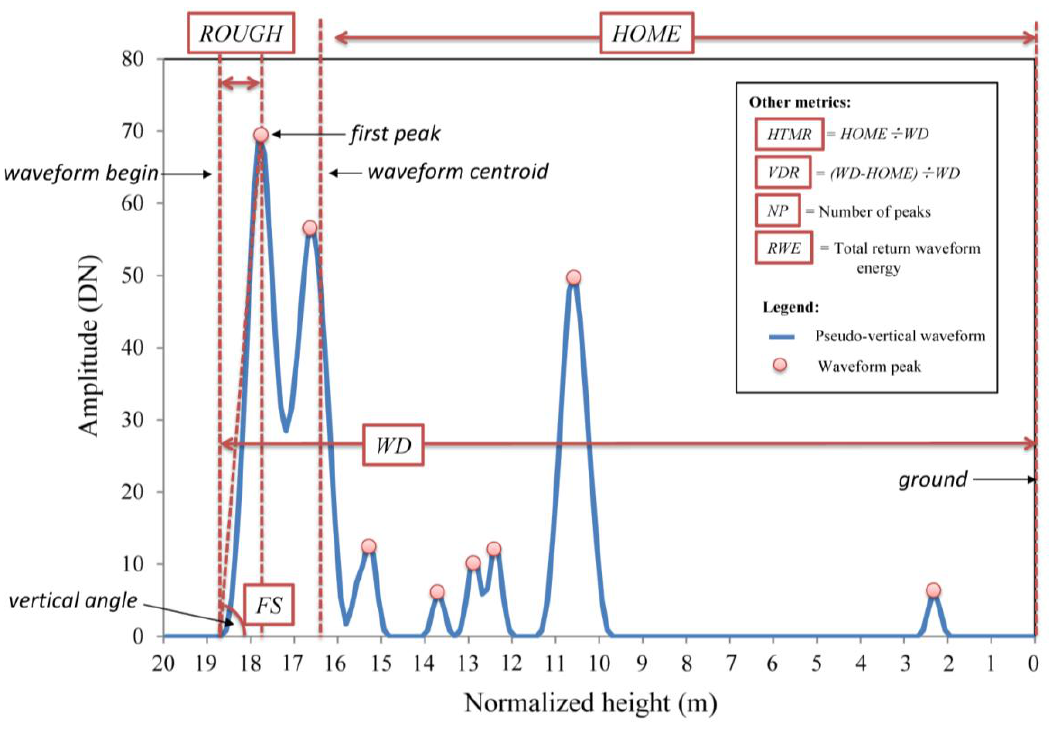
Figure 3. Illustration of a typical Pseudo-vertical waveform in one sample plot. In this example, the full-waveform record has been normalized by computing the difference between their height and the DTM. Eight distinct peaks are apparent in the graph. The front slope angle (FS) is computed as the vertical angle from waveform beginning to the peak of first canopy return